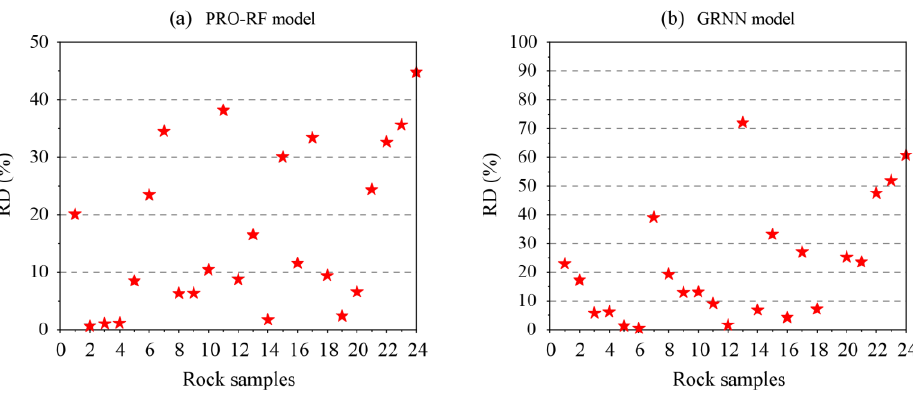
Figure 12. The RD distribution diagrams of the PRO-RF model and the GRNN model.